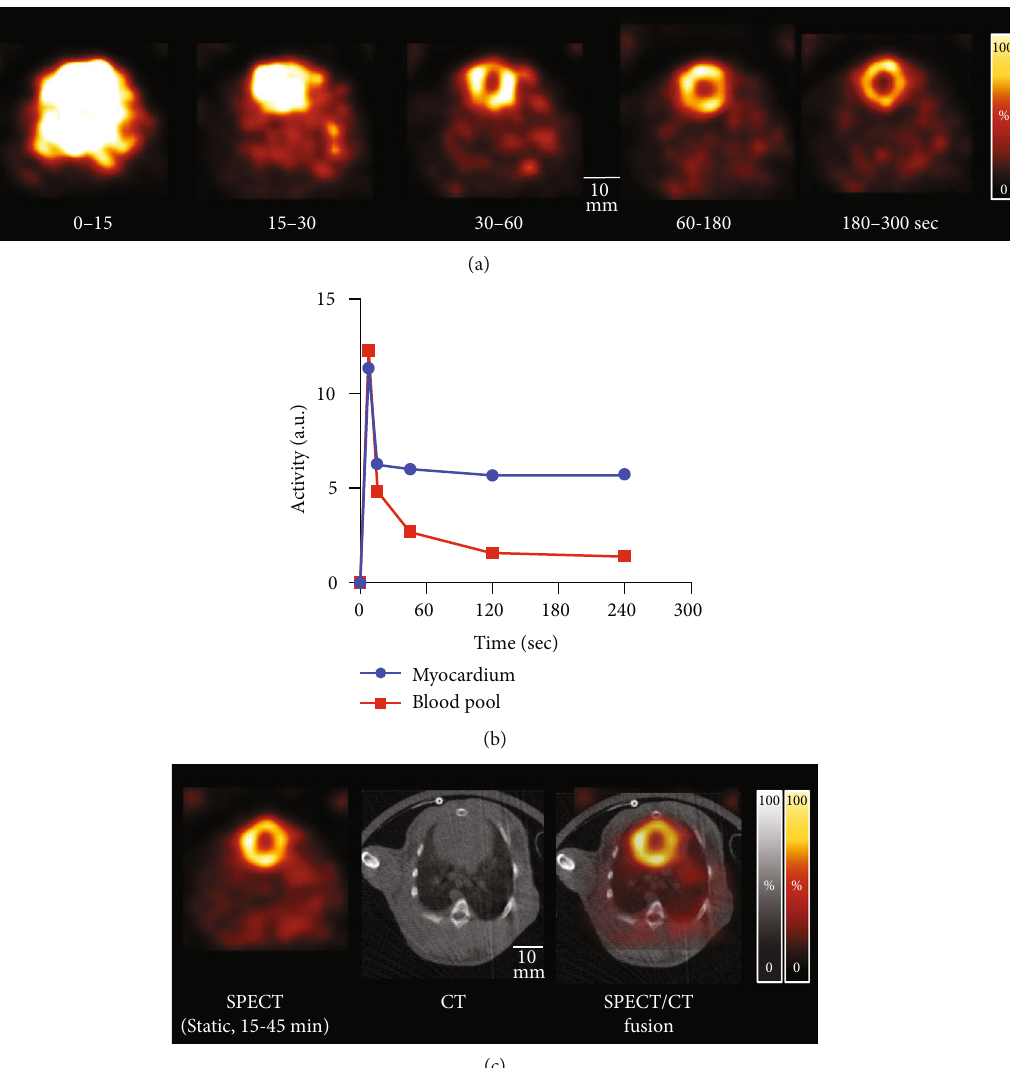
Figure 4: Dynamic [ 99m Tc]Tc-MIBI SPECT data of a rabbit ’ s thorax. (a) Transaxial dynamic SPECT images at the level of the heart during 5min after intravenous injection. (b) Time activity curves of the myocardium and blood pool during a 5 min dynamic scan. a.u.: arbitrary unit. (c) Fusion image at the (CT-based) level of the myocardium and static SPECT image during 15-45min after tracer